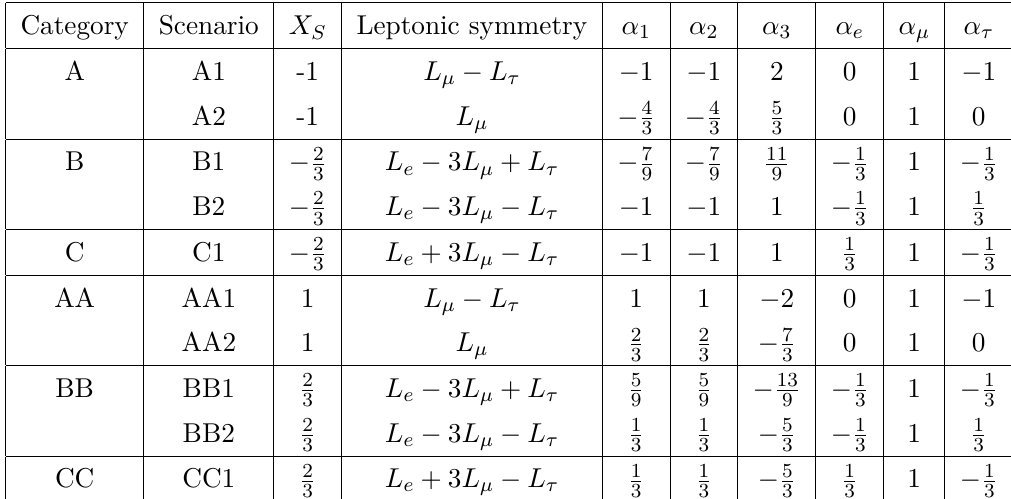
values are the same as given in ref. [29], while S S